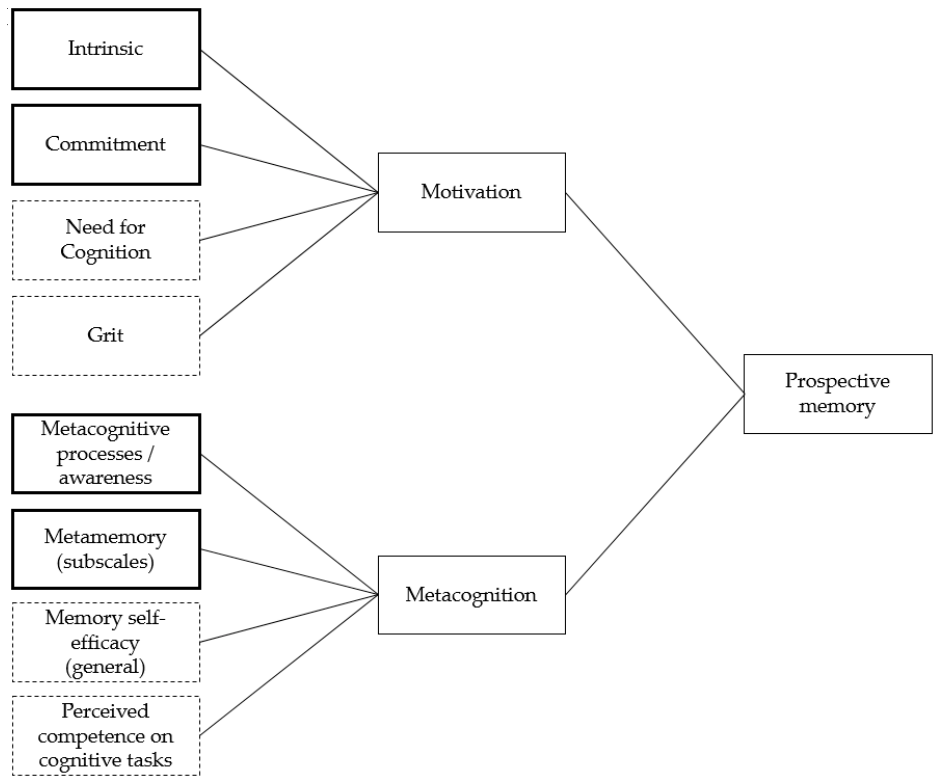
Figure 1. Motivation and metacognition dimensions studied in relation to prospective. Note: Thick, continuous boxes represent previous research, and thin, dashed boxes represent our present re- search.